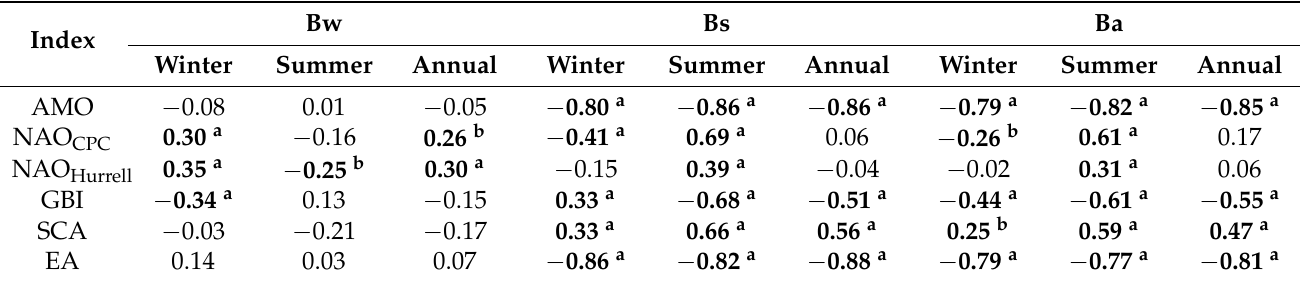
Table 8. Spearman correlation coefficients of Bw, Bs, and Ba versus seasonal and annual indices. Superscripts a–b specify the significance level of correlations at p < 0.05 and p < 0.10,